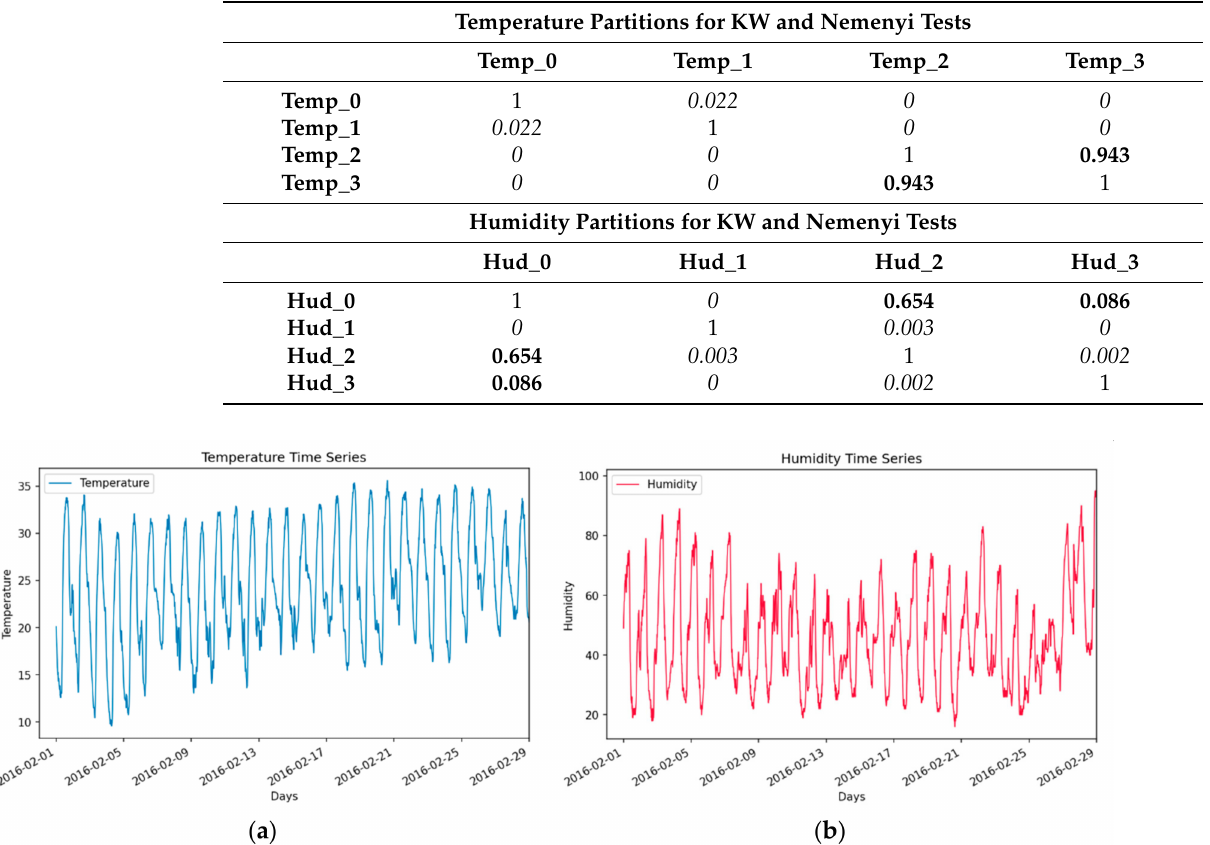
Table 1. Temperature and Humidity Partitions for applying the Kruskal–Wallis and Nemenyi Tests. Values in italics denote a significant difference in pair-wise relation while values in bold denote partitions negligible difference.